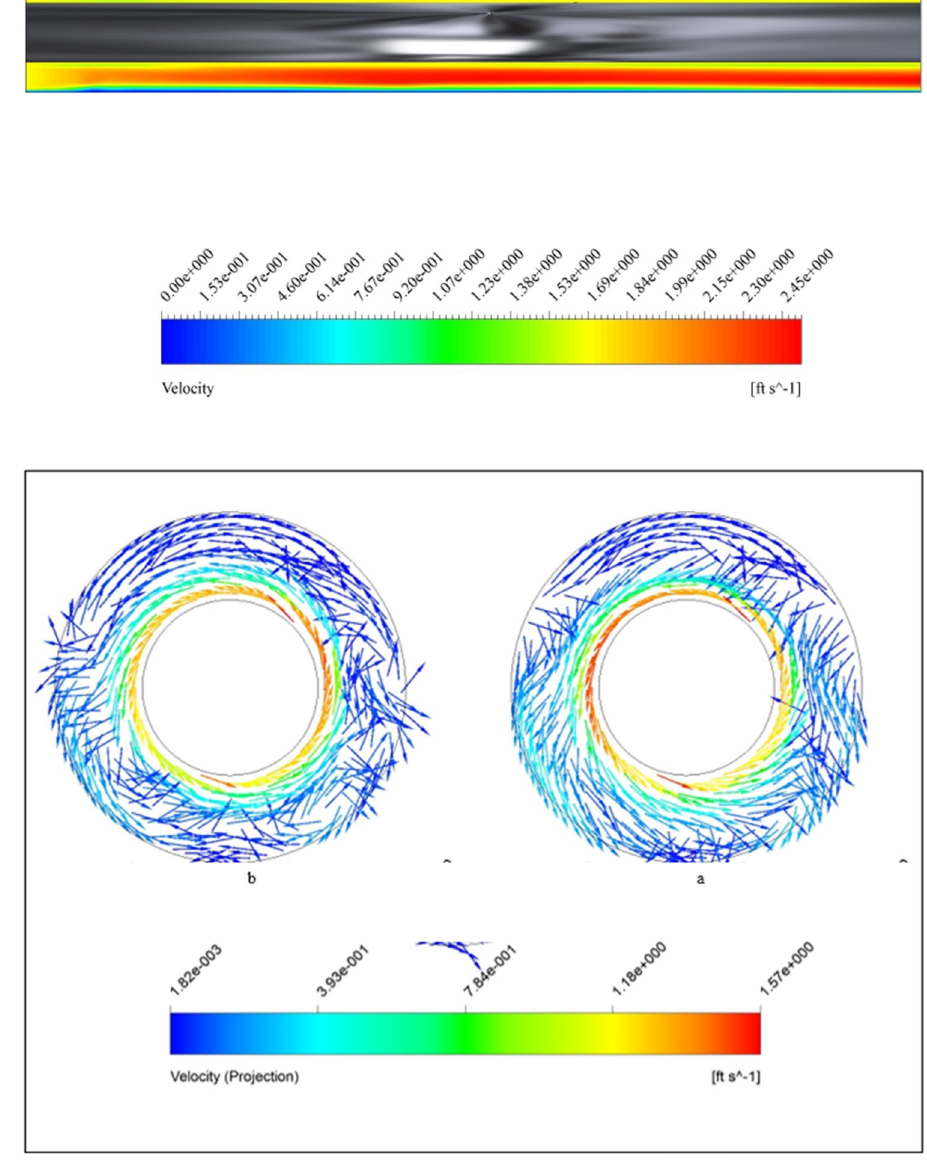
Fig. 9 Velocity contour of drill- ing fluid in a horizontal cross section